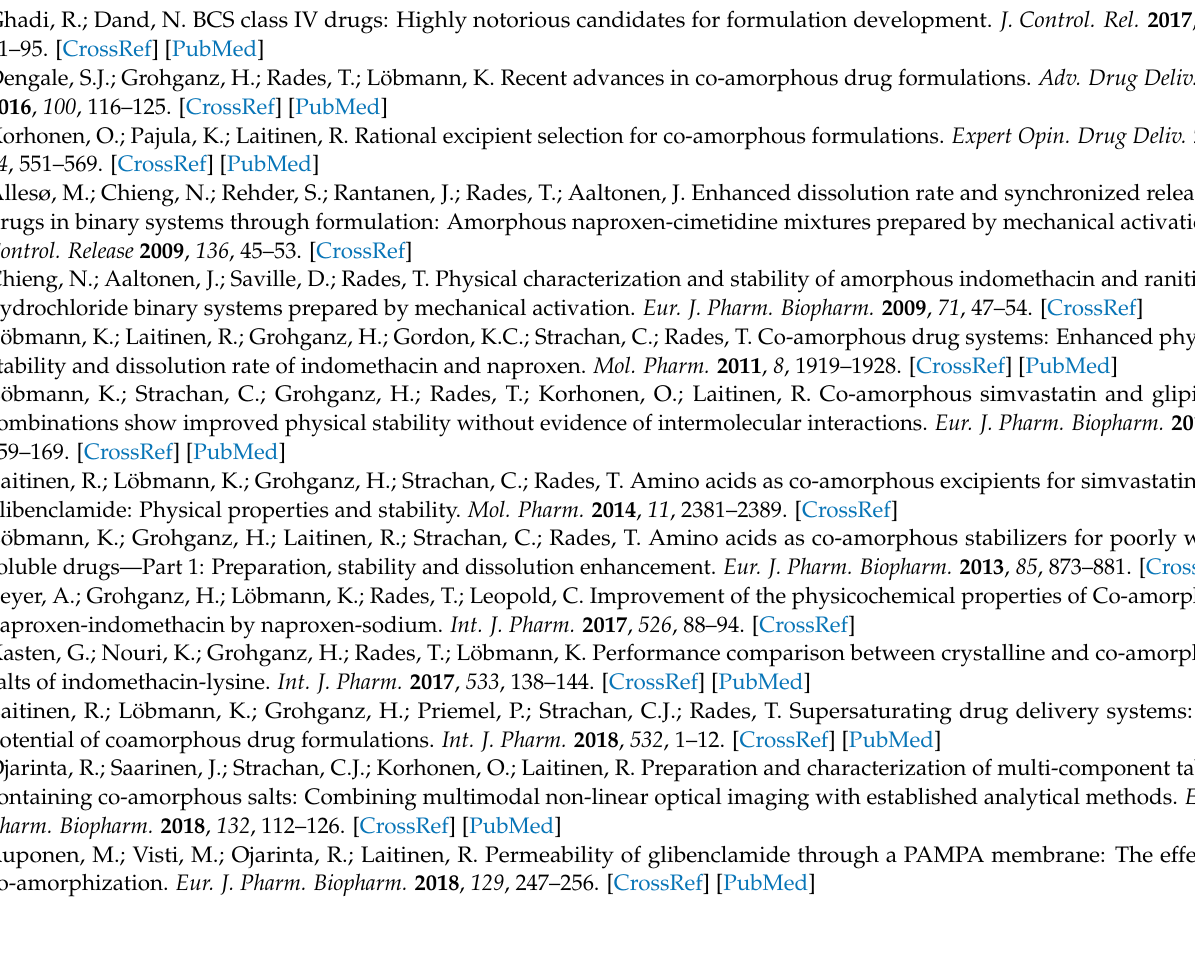
method. Figure S3: Example thermograms (second heating cycle) of the crystalline starting materials furosemide (FUR), verapamil hydrochloride (VER) and piperine (PIP) showing glass transitions (Tg, midpoint). Figure S4: Example thermograms of the co-amorphous mixtures of furosemide (FUR), verapamil hydrochloride (VER), piperine (PIP) and arginine (ARG) at 1:1 and 1:2 molar ratios. Figure S5: Fourier-transform infrared (FTIR) spectra of the co-amorphous materials after storage at 4 ◦ C/0% RH, 40 ◦ C/0% RH and 25 ◦ C/60% RH. Figure S6: The correlation between the AUC values for dissolution and permeation. Table S1: Outlet temperatures, inlet temperatures, pump rates and flow rates for the co-amorphous mixtures prepared by spray